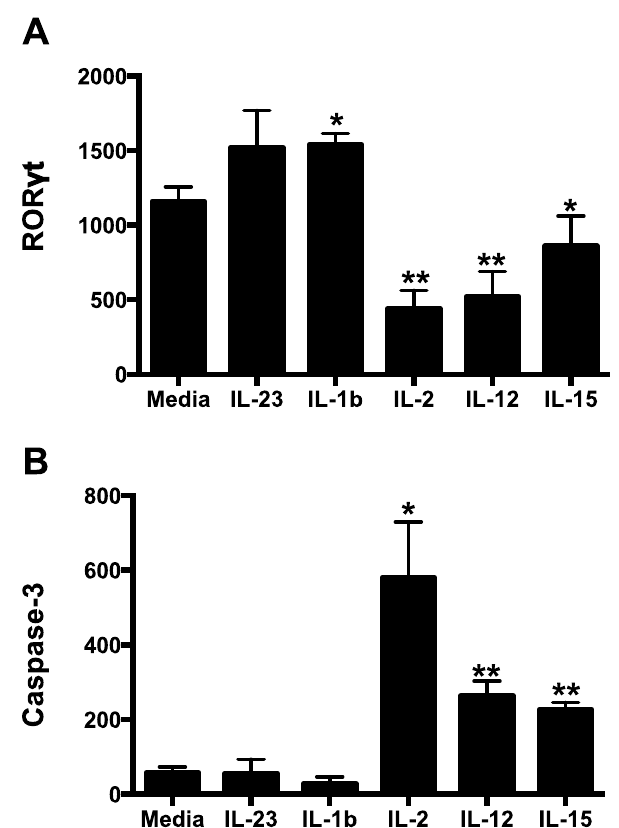
Fig. 7. Intracellular ROR c t and caspase-3 levels in cytokine cultured NKp44 + ILCs. NKp44 + ILCs were cultured overnight in various cytokines and ROR c t (A) and caspase-3 (B) were quantified intracellularly by flow cytometry. Bars represent mean 6 SEM of 5 independent experiments. Student’s t test was used to compare media control to each cytokine-treated culture; * p , 0.05, ** p , 0.01. MFI, median fluorescence intensity.